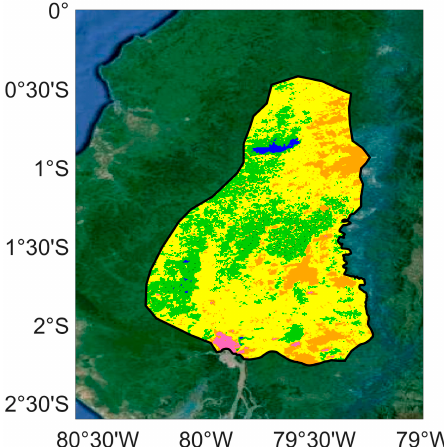
Figure 5. Land use from ENVISAT ASAR GM images acquired during the dry seasons (June to November) between 2005 and 2008, as determined by k-nearest neighbors supervised classification. The resulting classes are the followings: open water (blue), permanent crops (green), seasonal crops (orange), grazing fields (yellow), cities (pink). The boundary of the lowland is represented using a black line. Background image is from Google Maps.